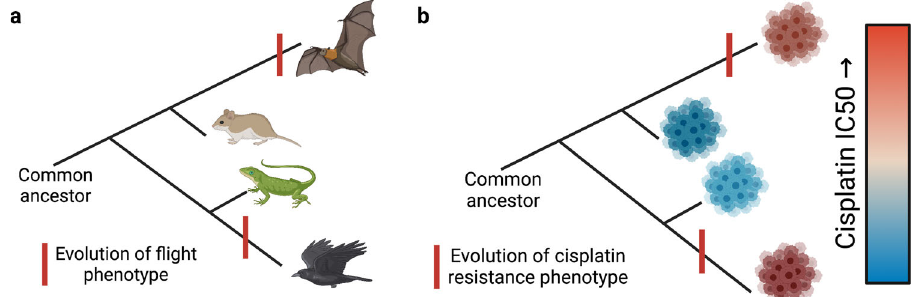
Fig. 1 Visual representation of convergent evolution in animals and convergent phenotypes in tumors. a Birds and bats are genomically disparate, but both have individually evolved the ability to fl y. b Two tumors may evolve cisplatin resistance independently, despite being genomically distinct from one another. Created with